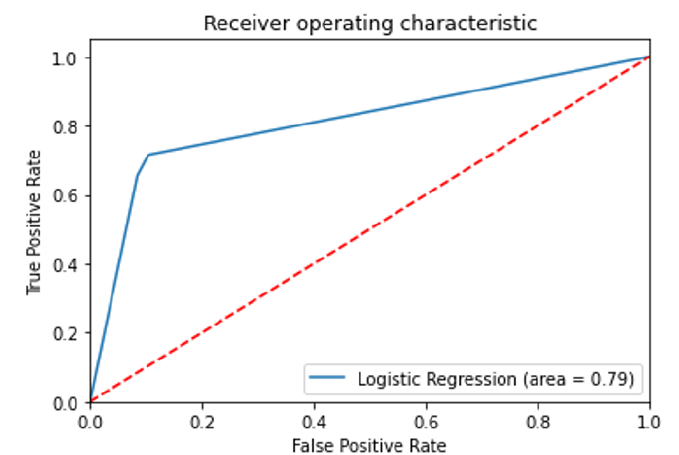
Figure 5. ROC curves for Logistic Regression